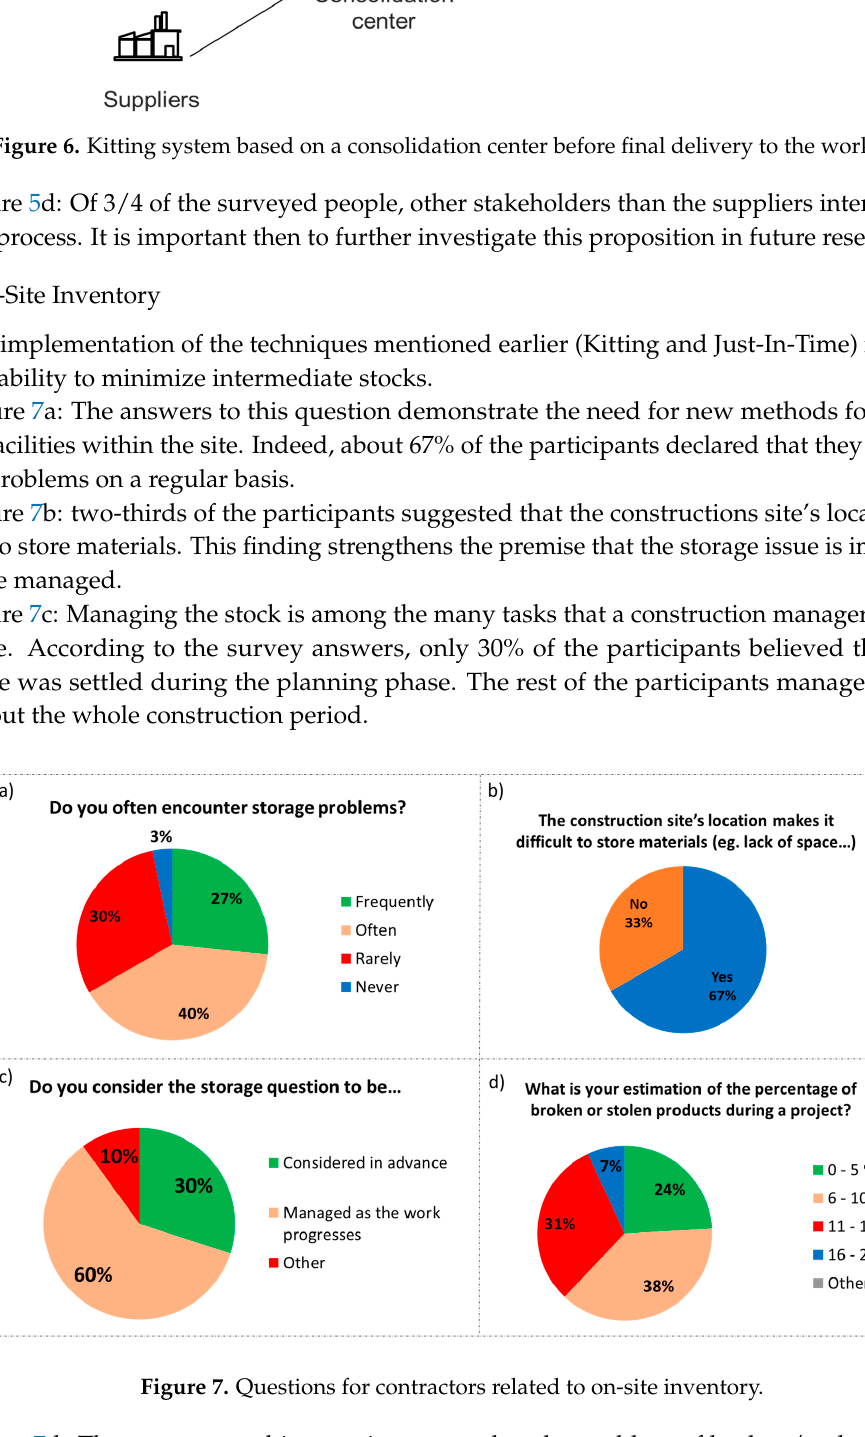
Figure 7d: The answers to this question prove that the problem of broken/stolen products